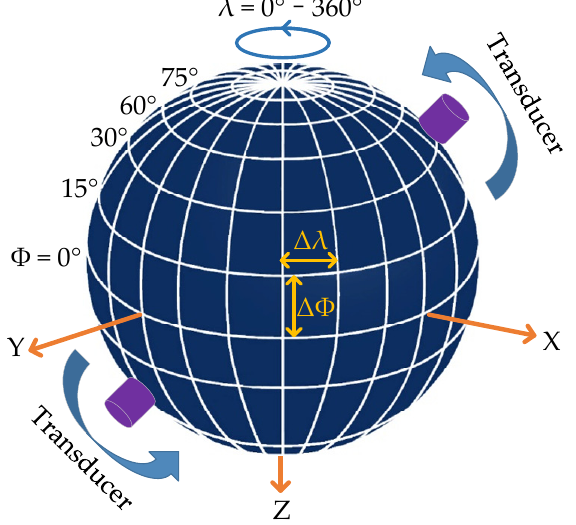
Figure 3. Schematic of measurements conducted by the 3-D measurement device.